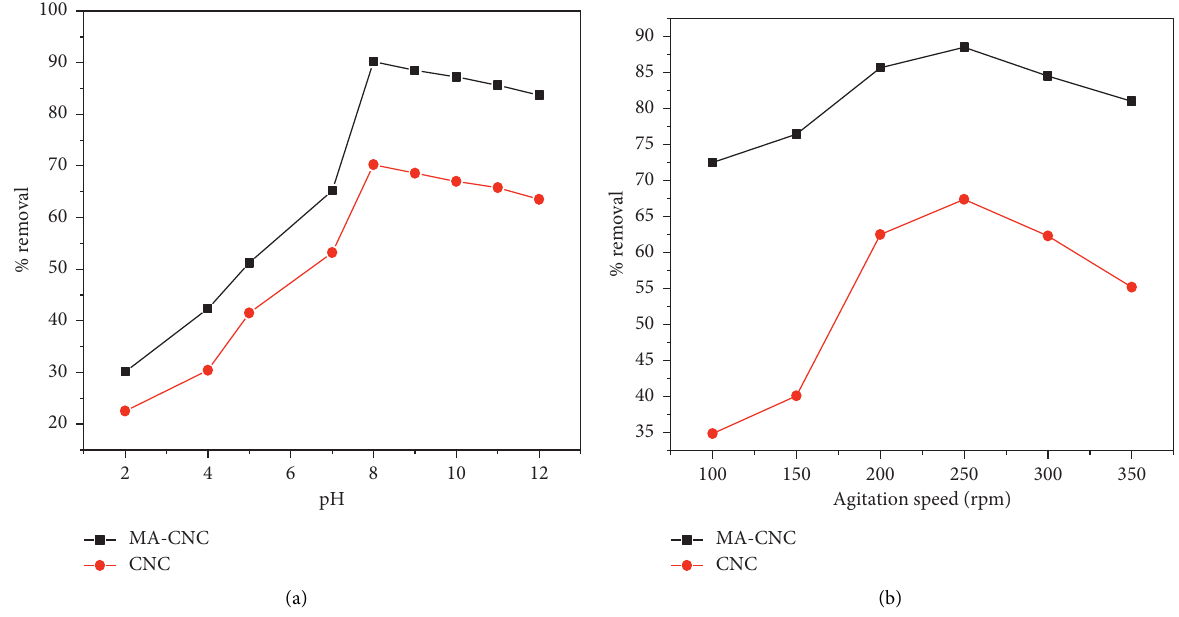
Figure 7: The effect of pH (a) and agitation speed (b) for the removal of Cd(II) ions from wastewater at an optimum initial concentration of 2mg/L, contact time of 120min, temperature of 20 ° C, and adsorbent dosage of 0.5g, respectively.